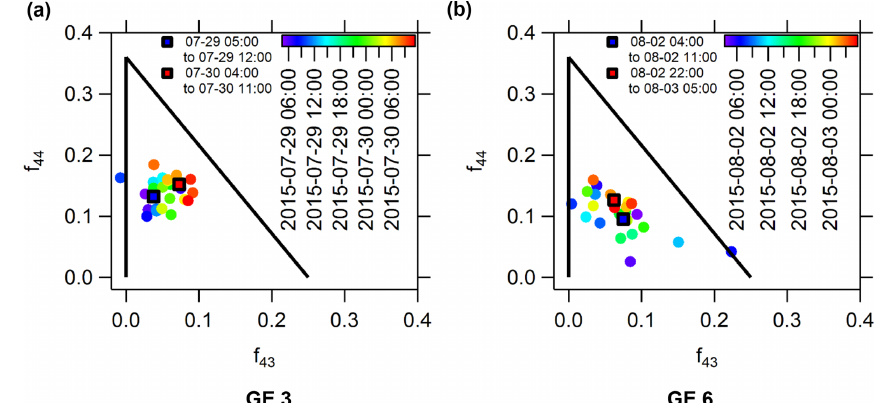
Figure 9. Scatter plot of the organic aerosol fraction measured at m/z 43 versus that measured at m/z 44 during GE 3 (a) and GE 6 (b) near Eureka. Also shown are the average values corresponding to the first 7h and final 7h of the growth event.